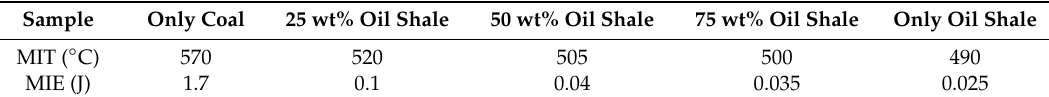
Table 2. Minimum ignition temperature (MIT) and minimum ignition energy (MIE) of the dust cloud.